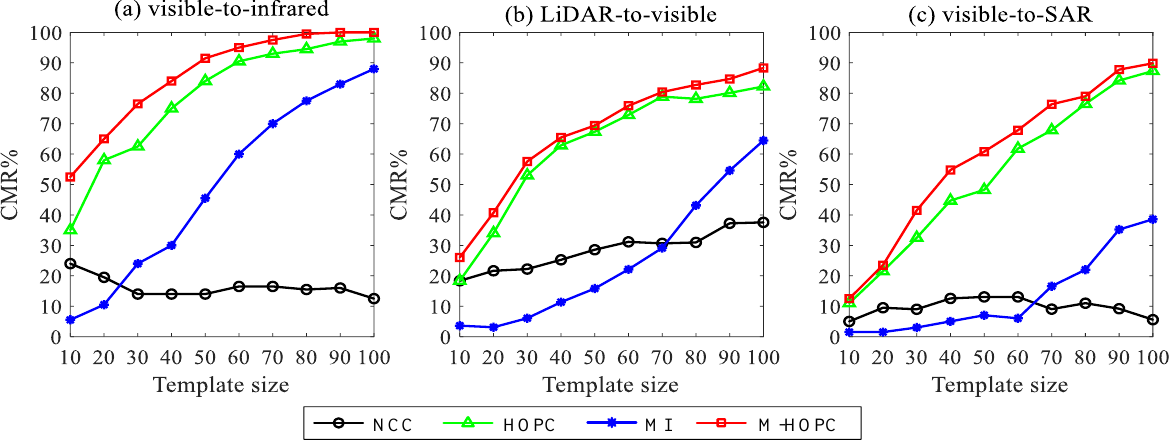
Figure 6. CMR values versus the template sizes of different similarity measures.